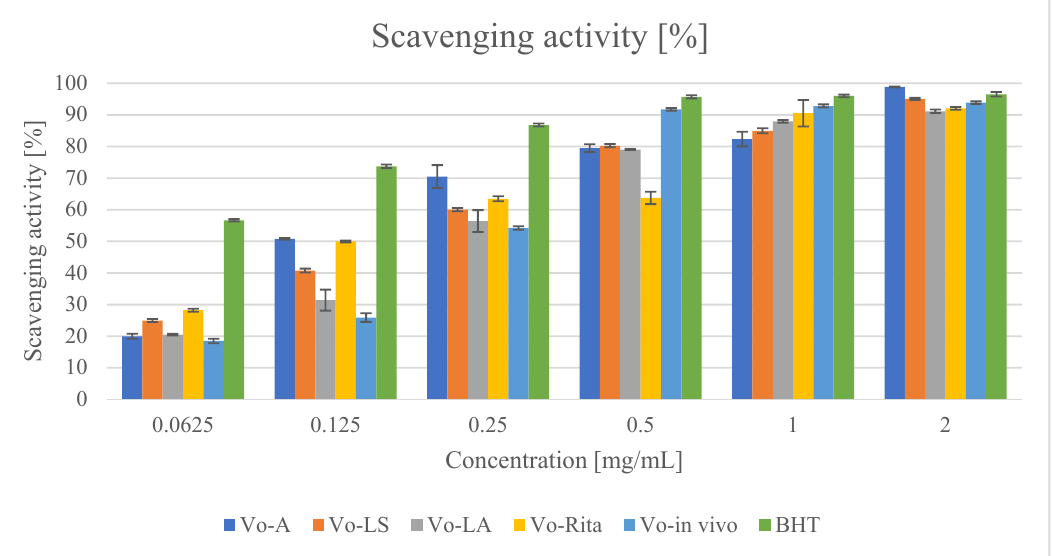
Figure 3. Free radical scavenging activity of extracts of V. officinalis in vitro cultures; agar (Vo-A), stationary liquid (Vo-LS), agitated (Vo-LA) and bioreactor cultures (Vo-RITA) and of plant material (Vo-in vivo). Values are expressed as mean ± SD (n = 3).